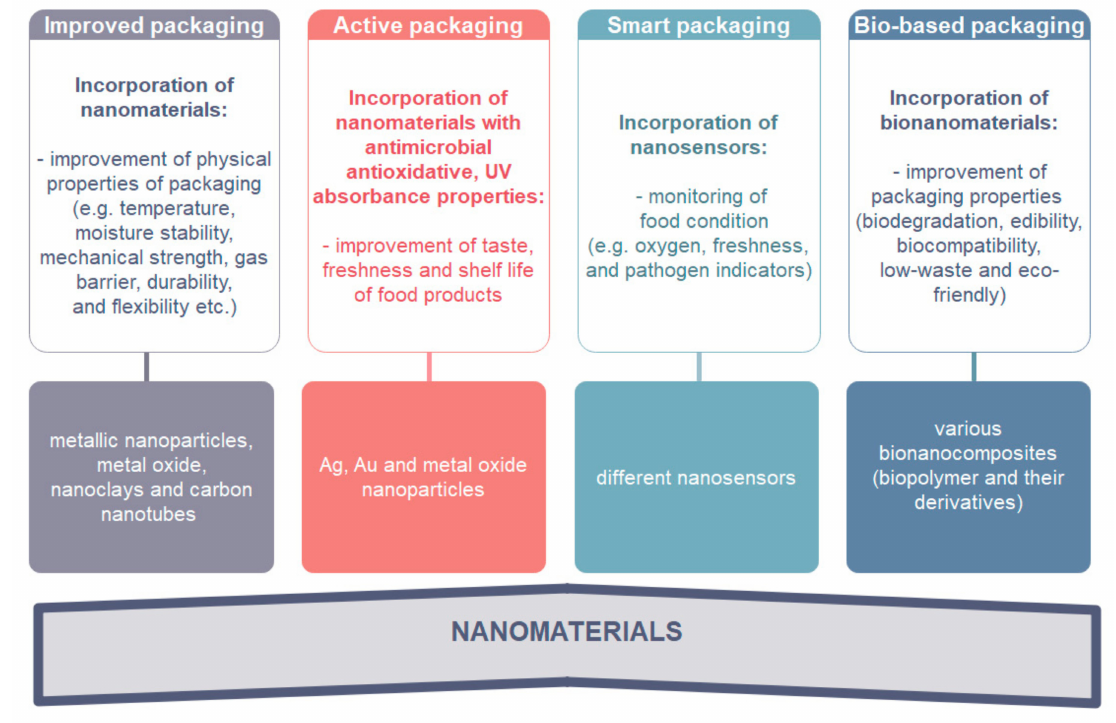
Figure 2. Classification of food packaging based on functional nanomaterials [10].